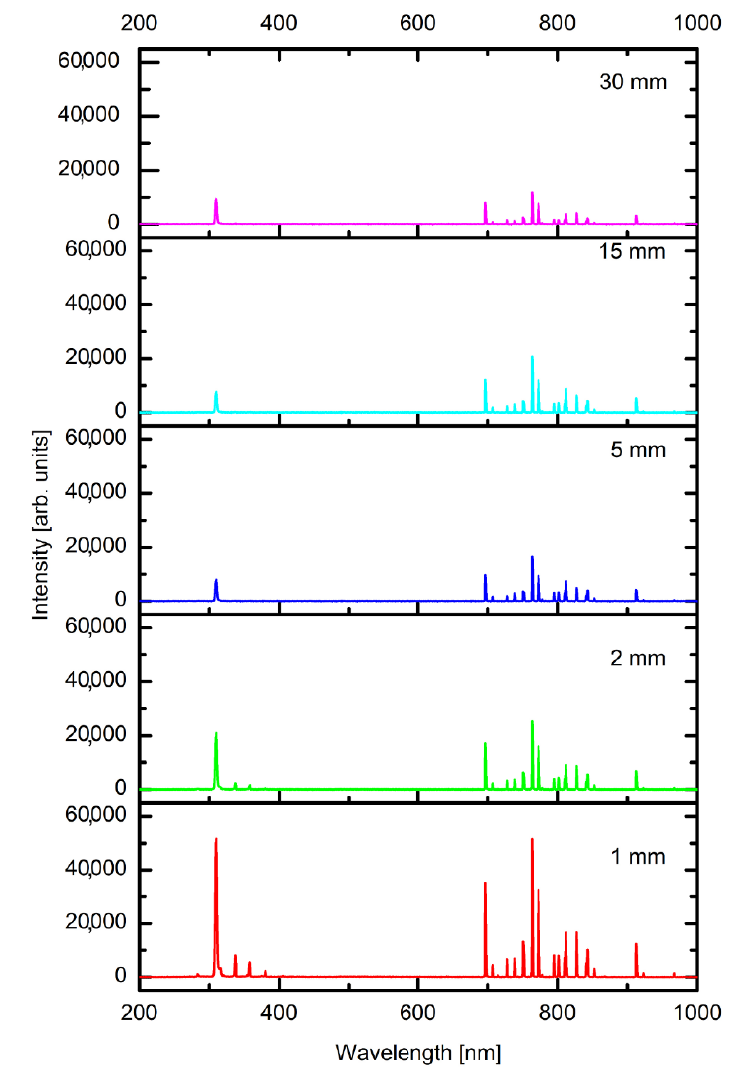
Figure 5. Optical spectra acquired at various distances between the nozzle and the sample. All spectra were acquired with the optical fibre tip placed 2 mm below the nozzle and lenses of an acceptance angle of approximately 3°.